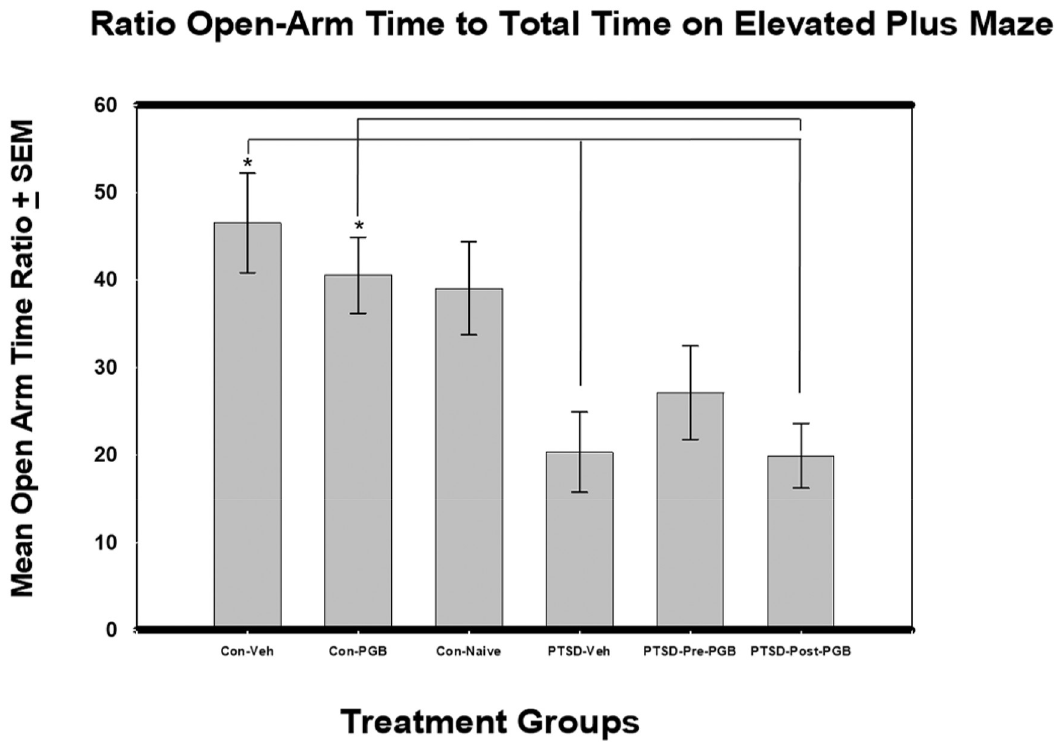
Fig 4. ANOVA of Mean Open-Arm Time Ratio (percent) from Elevated Plus-Maze (EPM) and Standard Error of the Mean (SEM). Each of the main two groups (Stressed and Non-stressed) had three subgroups: non-stressed: control vehicle, control PGB, control na ï ve, and stressed: Posttraumatic stress disorder (PTSD) vehicle, PTSD Pre-PGB (prophylactic), PTSD Post-PGB (non- prophylactic). Asterisks denote statistical significance at p < .05. PTSD vehicle and PTSD Post-PGB post-treatment had significantly lower mean open arm time ratio when compared to control. PTSD Post-PGB had significantly lower mean open arm time ratio when compared to Control